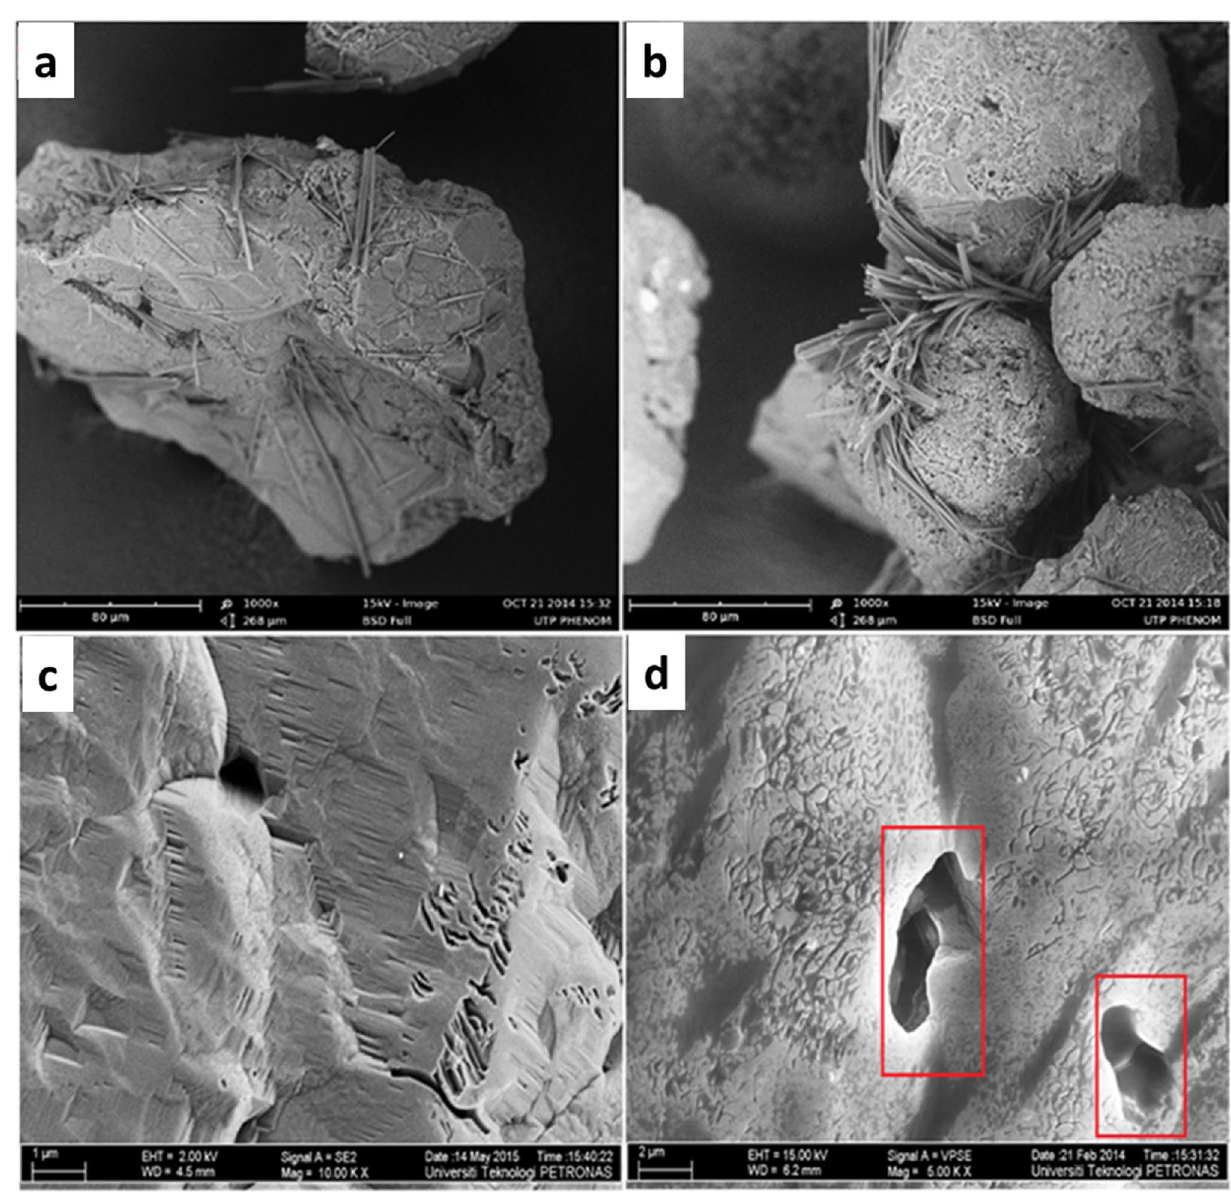
Fig. 14 FESEM of quartz surface showing: a needle-like shaped laths of sodium silicate sorbed on the quartz surface, b laths of sodium silicates are also shown bundled between quartz, c striations and curved trails, d etch